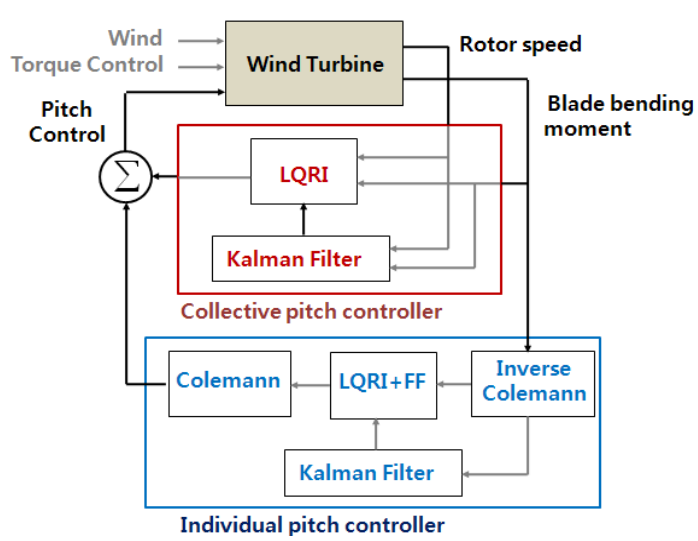
Figure 2. Blade pitch control